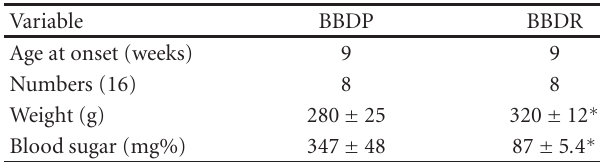
Table 1: Demographic and laboratory variables (MEAN ± SD) of diabetic rats (BBDP) and resistant rats (BBDR) at onset of